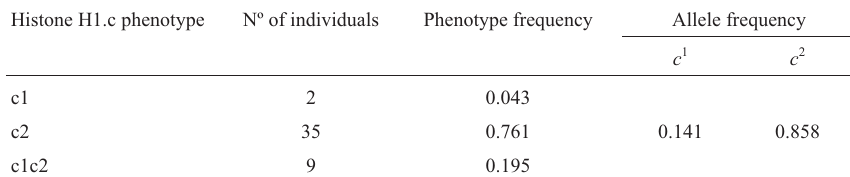
Table 1 - Phenotype and allele frequencies of pheasant erythrocyte histone